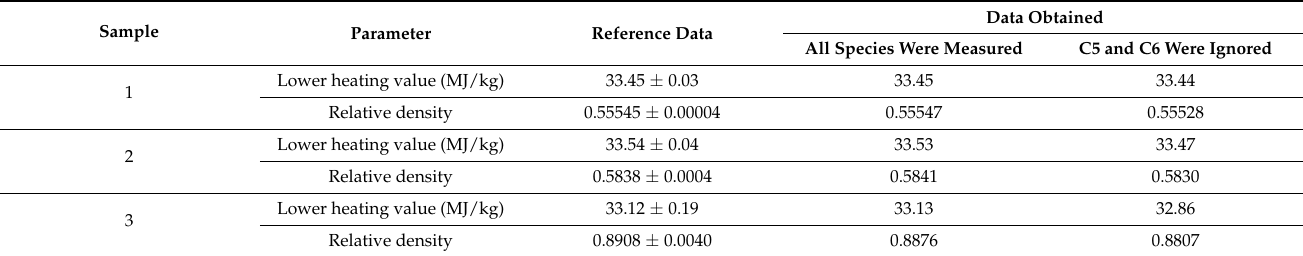
Table 8. Comparison of characteristics of natural gas samples.